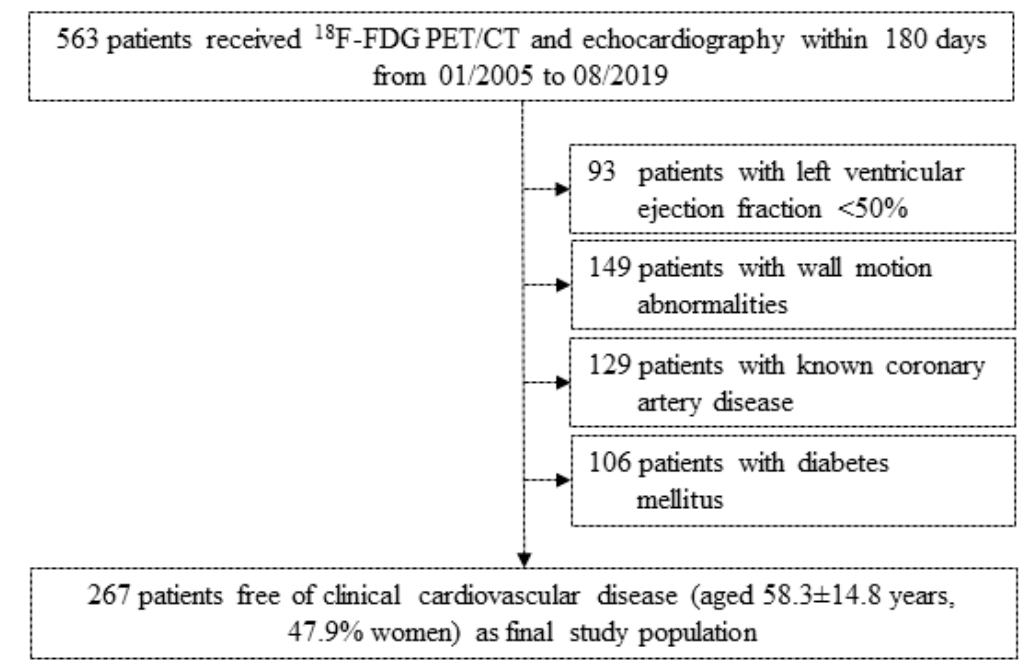
Figure 1. Clinical study cohort. Study flow chart visualizing initial complete study cohort and excluded patients on pre-defined criteria (left ventricular ejection fraction, motion abnormalities, known coronary artery disease, and diabetes mellitus). Totally 267 patients free of clinical cardiac disease entered the final study population for statistical investigation.